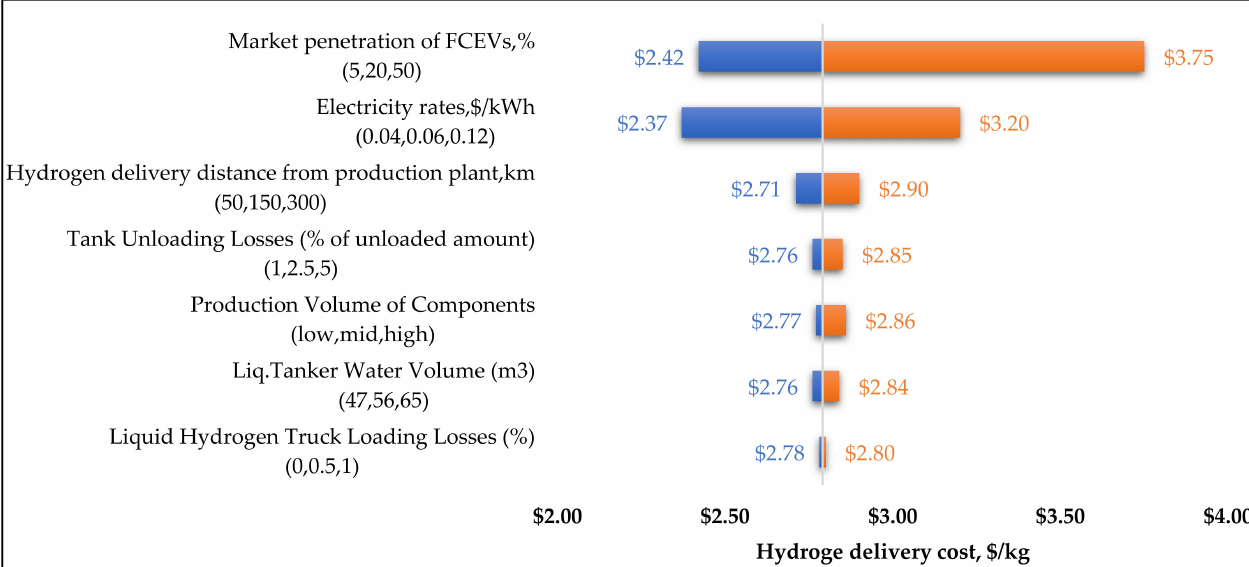
Figure 14. Range of liquid hydrogen tanker delivery costs to a 1.5 tpd refueling